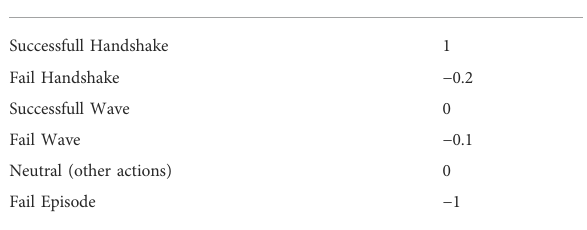
TABLE 1 Default rewards for